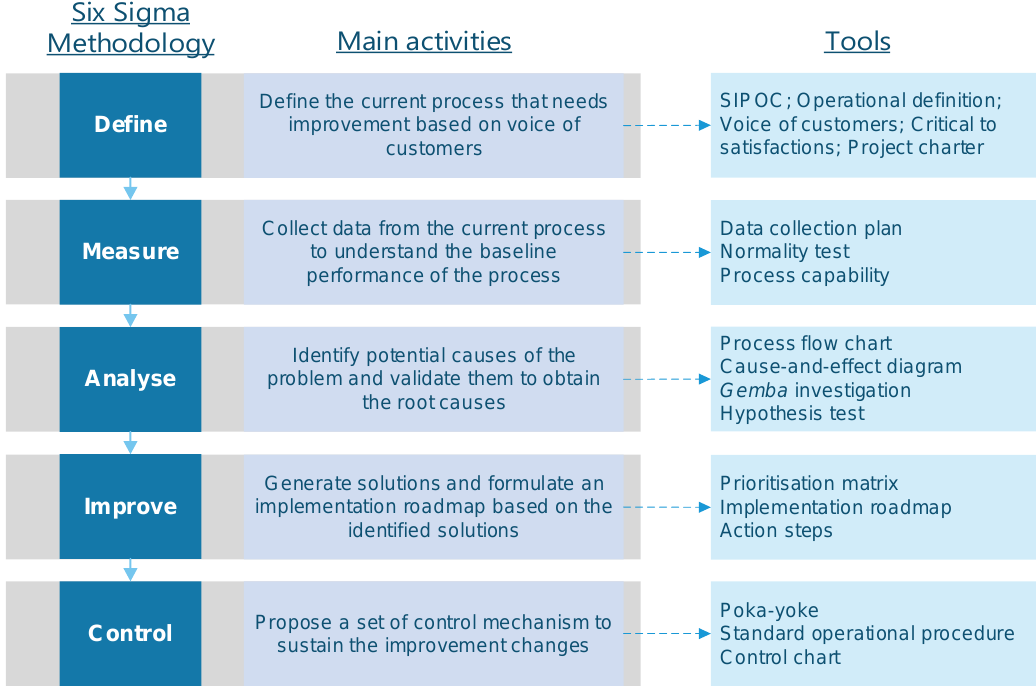
Figure 1. DMAIC framework and Six-Sigma